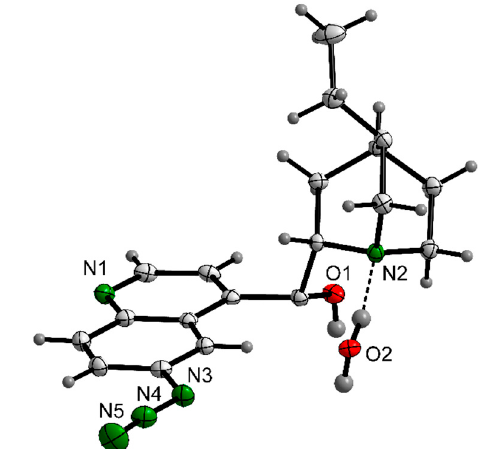
Figure 4. The X-ray analysis for azide 10 and 11 .